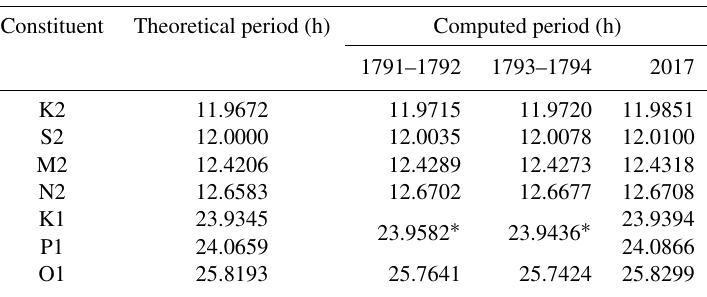
Table 1. Summary of the seven main tidal constituents for Trieste, their theoretical periods and the periods computed with the periodogram analysis of the 1791–1792, 1793–1794 and 2017 data. The asterisk indicates that the constituents were not discriminated by the analysis.